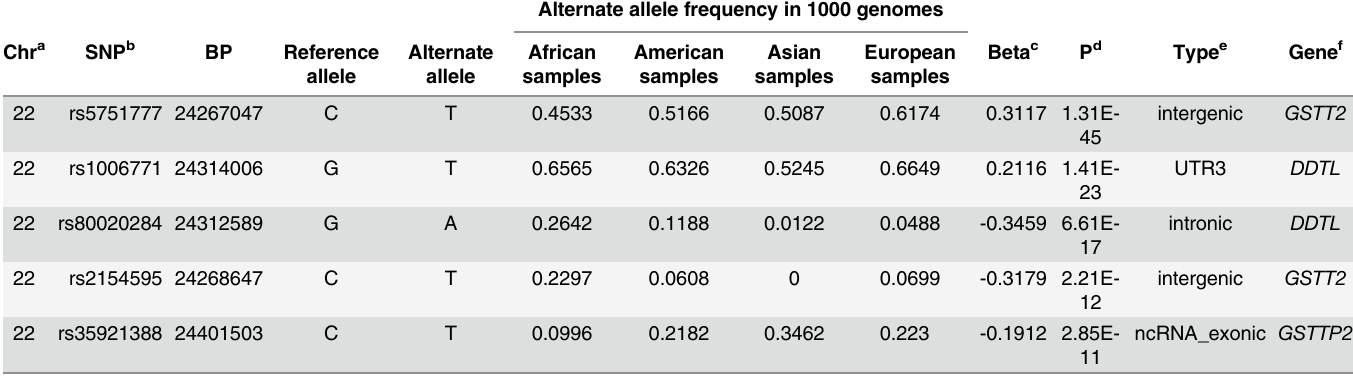
Table 6. Five significant variants remaining from stepwise regression